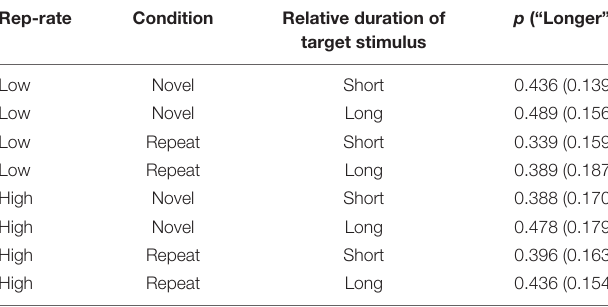
TABLE 2 | Mean proportions of trials on which the second face was judged to last longer than the first. Rep-rate